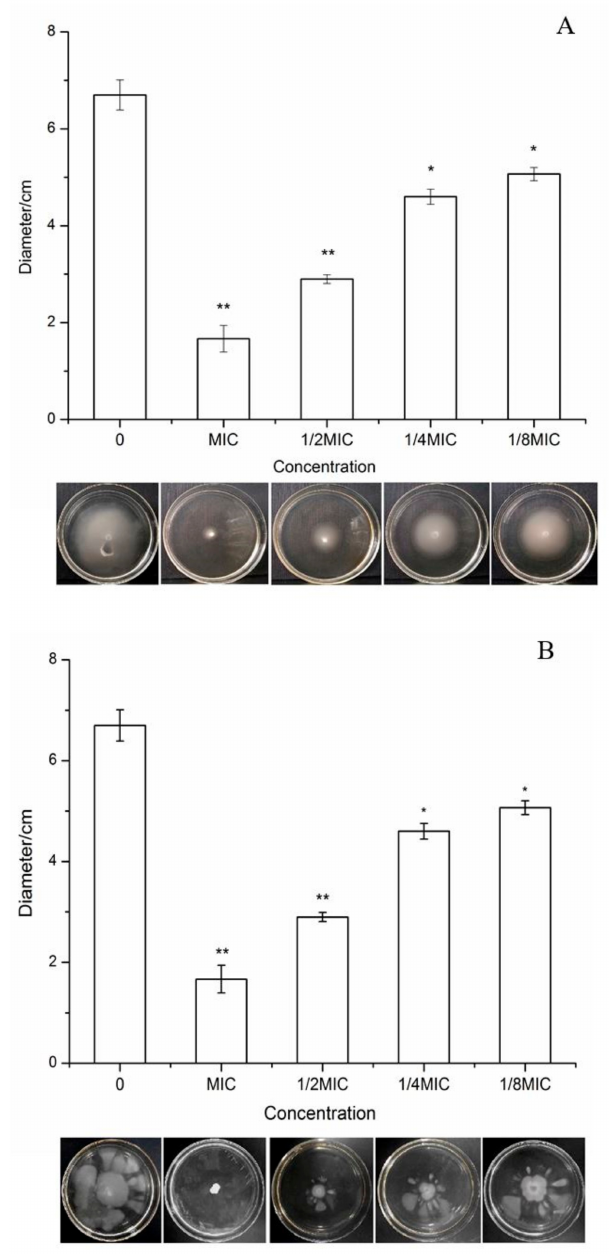
Figure 5. Inhibitory e ff ects of BITC at di ff erent concentrations on the motility of S. typhimurium . The bacteria were treated with BITC at di ff erent concentrations (MIC, 1 / 2MIC, 1 / 4MIC and 1 / 8MIC) at 37 ◦ C for 12 h ( A ) and 48 h ( B ), respectively, and the diameters were observed and measured. Figure A indicated the results of swimming and Figure B indicated the results of swarming. ‘*’ indicates significant di ff erences ( p < 0.05). ‘**’ indicates extremely significant di ff erences ( p <